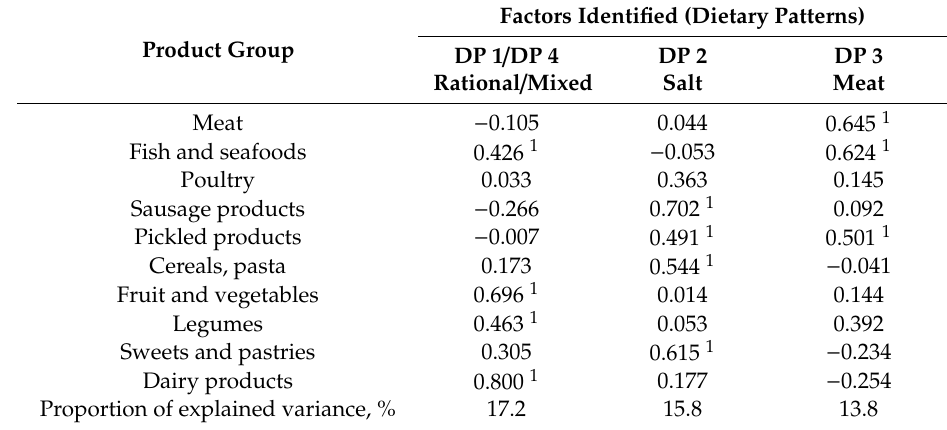
Table A12. Factor loadings of the principal dietary patterns identified (Ivanovo region).